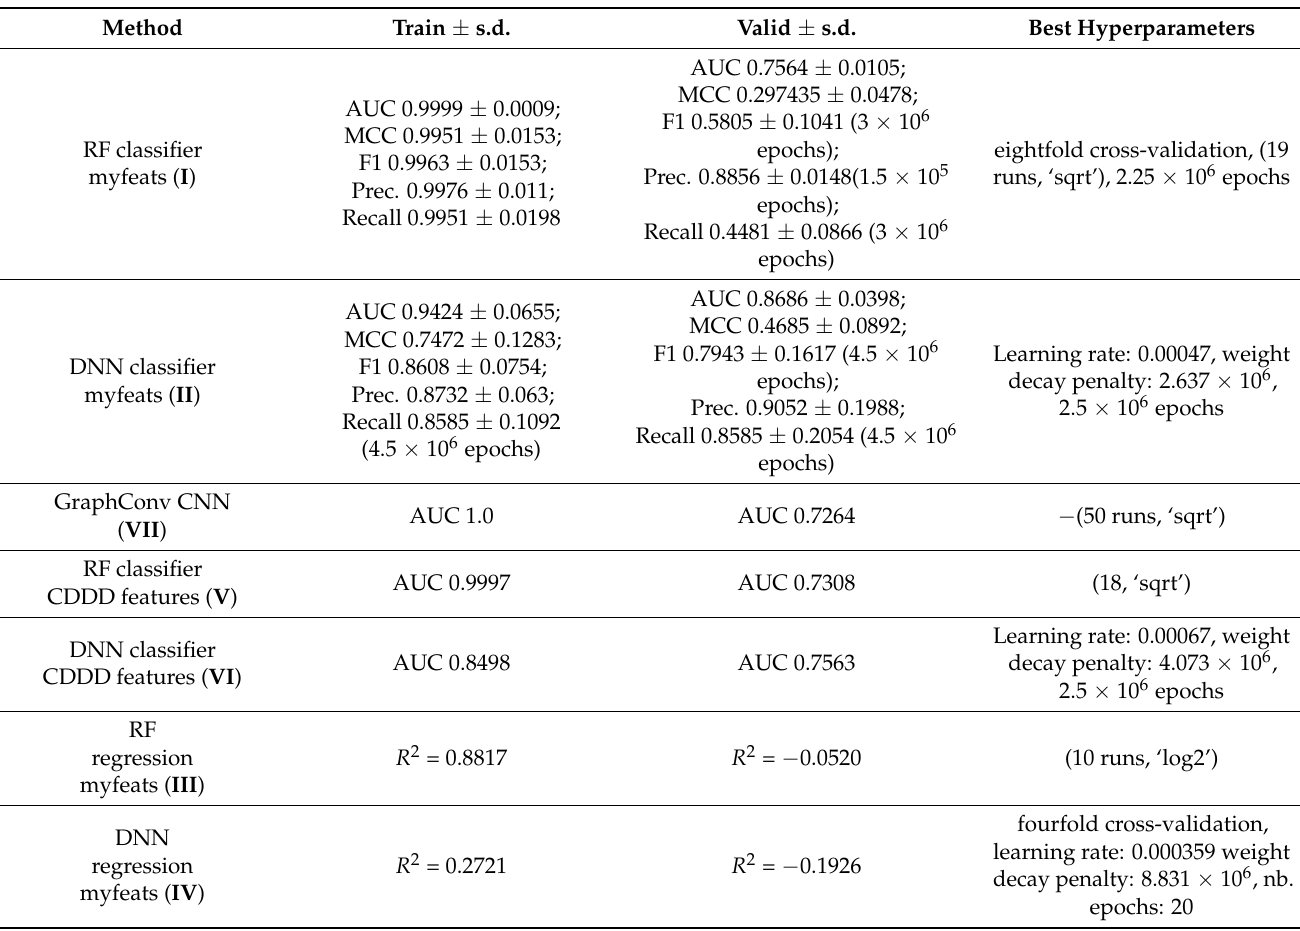
Table 1. Best methods obtained for different algorithms and featurizations. Standard deviations (s.d.) included for the best methods. Train ± s.d. Valid ±